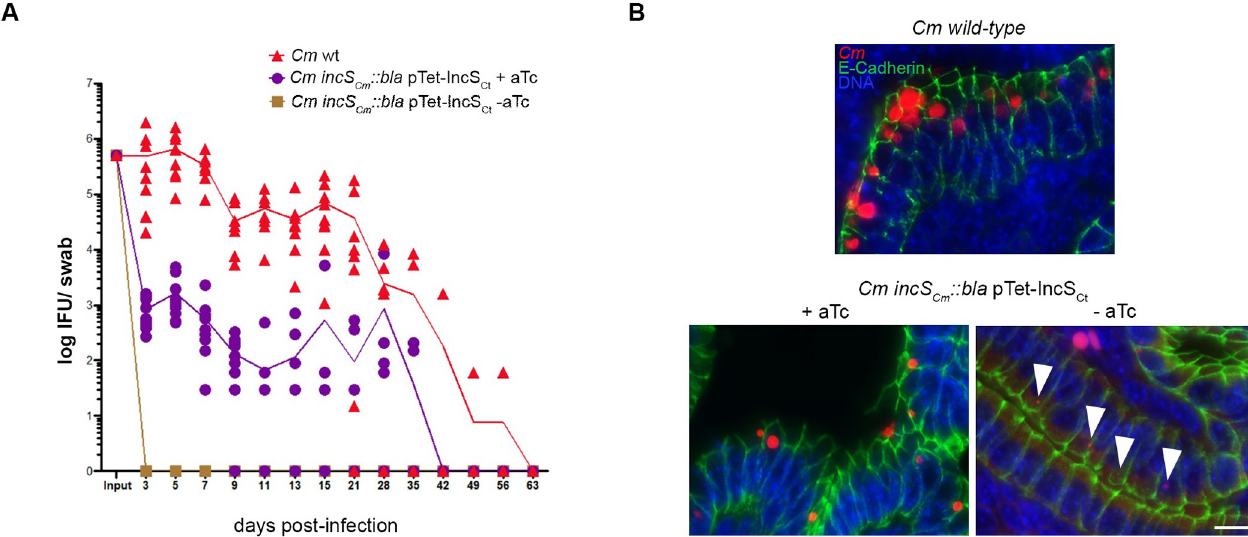
Fig 4. In vivo developmental defect of a Chlamydia muridarum incS conditional mutant. (A) Infectious progeny recovered at the indicated time from vaginal swabs after intravaginal inoculation of C3H/HeJ mice with wild-type C . muridarum (red triangles), or the incS Cm :: bla mutant complemented (purple circles) or not (brown squares) by addition of aTc to the drinking water. Each data point represents a mouse. Combined results from 2 independent experiments with 5 mice per group is shown. Mixed effect analysis with multiple comparisons and Tukey corrections: days 3–9 pi P < 0.0001 (all groups), day 11 pi P = 0.0464 (complemented vs mutant), day 13 pi not significant (complemented vs mutant). (B) Fluorescence microscopy images of paraffin sections of endometrial epithelium of C3H/HeJ mice transcervically infected for 8h with wild-type C . muridarum (top panel), or the incS (bottom left panel) or not (bottom right panel, arrowheads indicate intracellular bacteria) by addition of aTc to the drinking water and stained for DNA (blue), E-Cadherin (green) and C . muridarum (red). One representative mouse shown. Scale bar: 10 μ m.